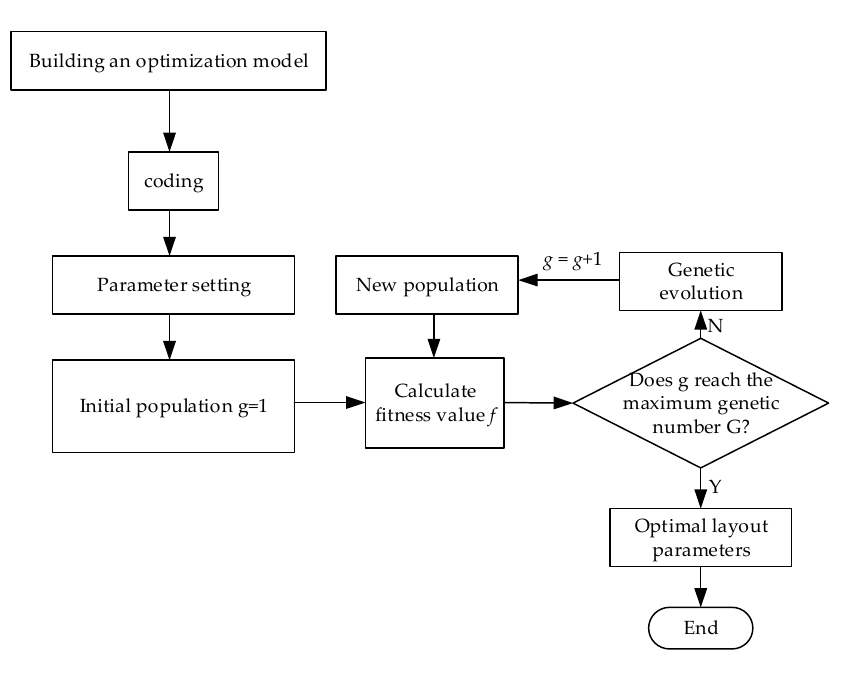
Figure 7. Algorithm solving flowchart.